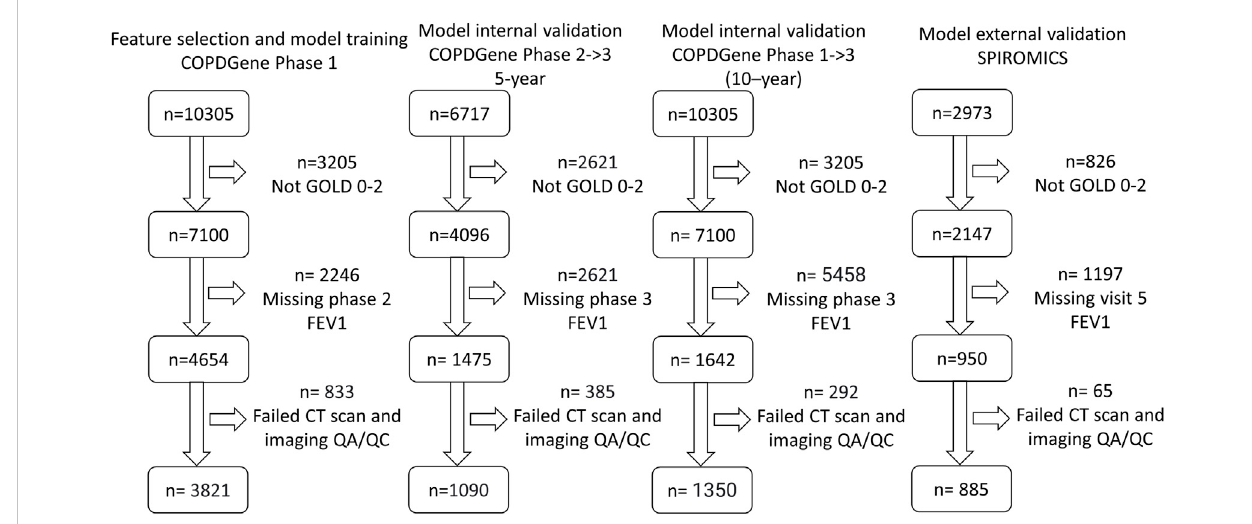
FIGURE 1 Consolidated Standards of Reporting Trials (CONSORT) diagram for model training. (COPDGene Phase 1), 5-year internal validation (COPDGene Phase 2 – 3), 10-year internal validation (COPDGene Phase 1 – 3), and external validation (SPIROMICS)